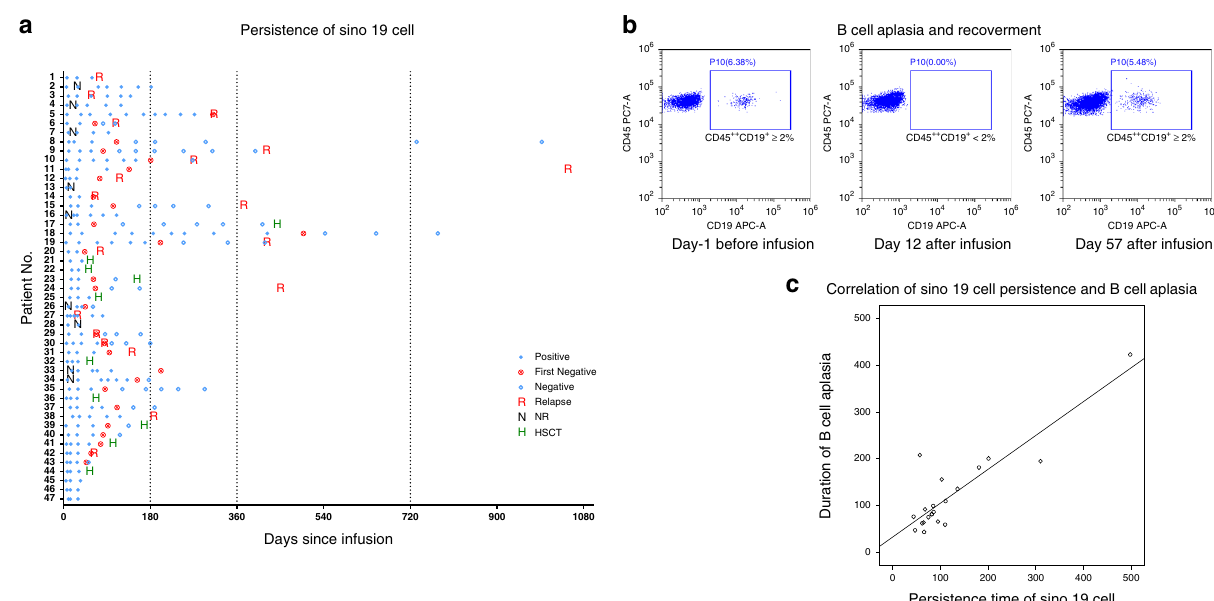
Fig. 4 Persistence of Sino 19 cell and B-cell aplasia. a Panel shows the results of Sino 19 cells detected by qRT-PCR in peripheral blood samples. The fi rst negative was de fi ned as the time of fi rst negative measurement by qRT-PCR. The median persistence time of Sino 19 cells for all patients who attained CR/ CRi was 85 days (range 44 – 498 days), excluding 10 patients that were bridged to allo-HSCT. 15 (78.9%) patients relapsed after the Sino 19 cell loss or at the same time; another 4 (21.1%) relapsed under the state of Sino 19 cell persistence (Nos. 1, 3, 27, and 38). Nine patients (Nos. 2, 4, 7, 13, 16, 26, 28, 33, and 34) failed to achieve CR/CRi (indicated by NR), however, Sino 19 cell was detected in their blood from day 1 to day 60 after the infusion. Two patients (Nos. 8 and 18) who did not bridge to allo-HSCT maintained continue remission and survived for more than 1 year after the Sino 19 cell loss. b The panel shows the detection of B cell in a patient before and after the infusion of Sino 19 cells; B-cell aplasia was de fi ned as CD45 strong and CD19-positive (CD19 + CD45 ++ ) B cells <2% in lymphocyte gate; recovery was de fi ned as ≥ 2%. c The panel shows that the persistence time of Sino 19 cells positively well correlated with the duration of B cell aplasia in patients who achieved CR/CRi without bridging to allo-HSCT ( p = 1.08e − 7, R = 0.884, by using two-sided Pearson correlation coef fi cient). Source data of ( a ) and ( c ) are provided as a Source Data fi le or available at https://doi.org/10.6084/m9. fi gshare.13136078.v1.